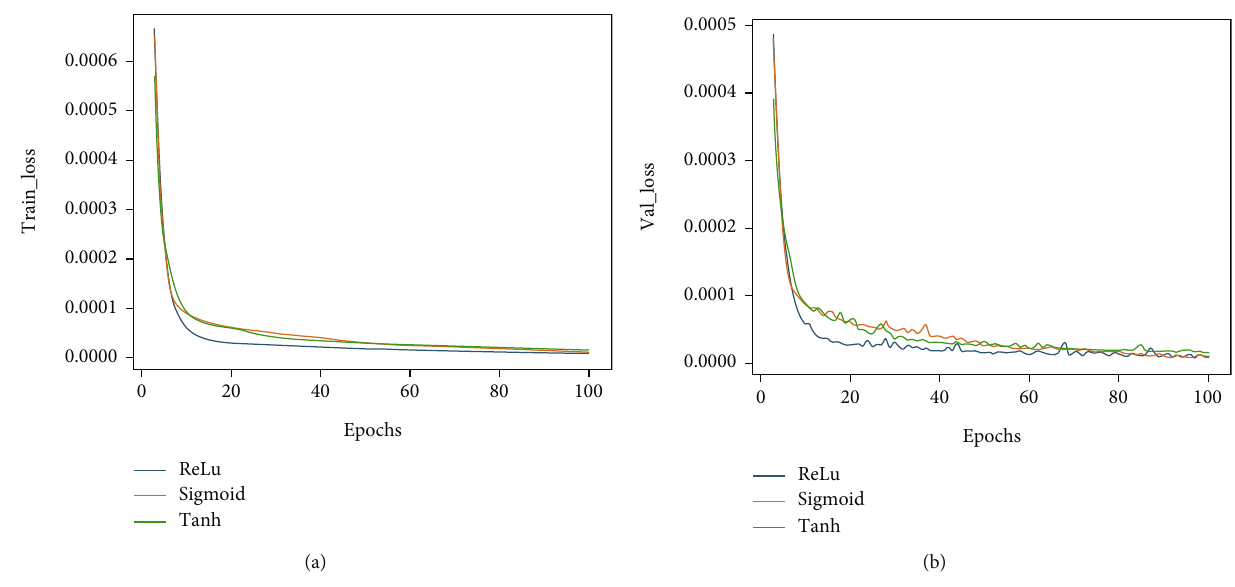
Figure 8: E ff ect of di ff erent activation functions on the